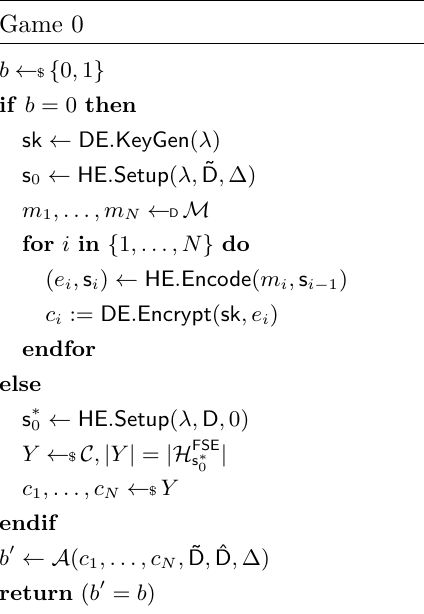
Figure 5: Sequence of games in the proof of smoothness of an ( HE , DE )- FSE scheme (continued on next